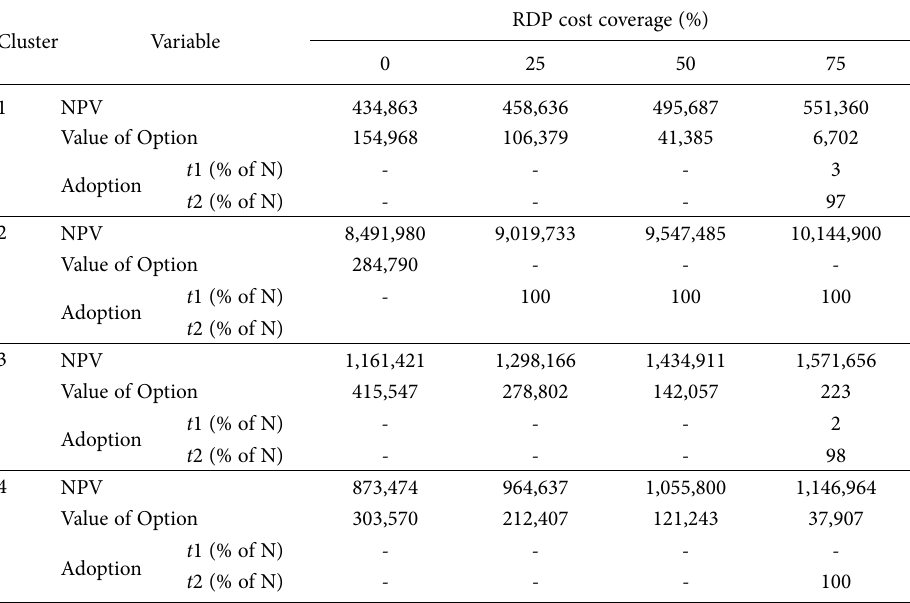
Table 4. Results with uncertainty in labour costs (€ per